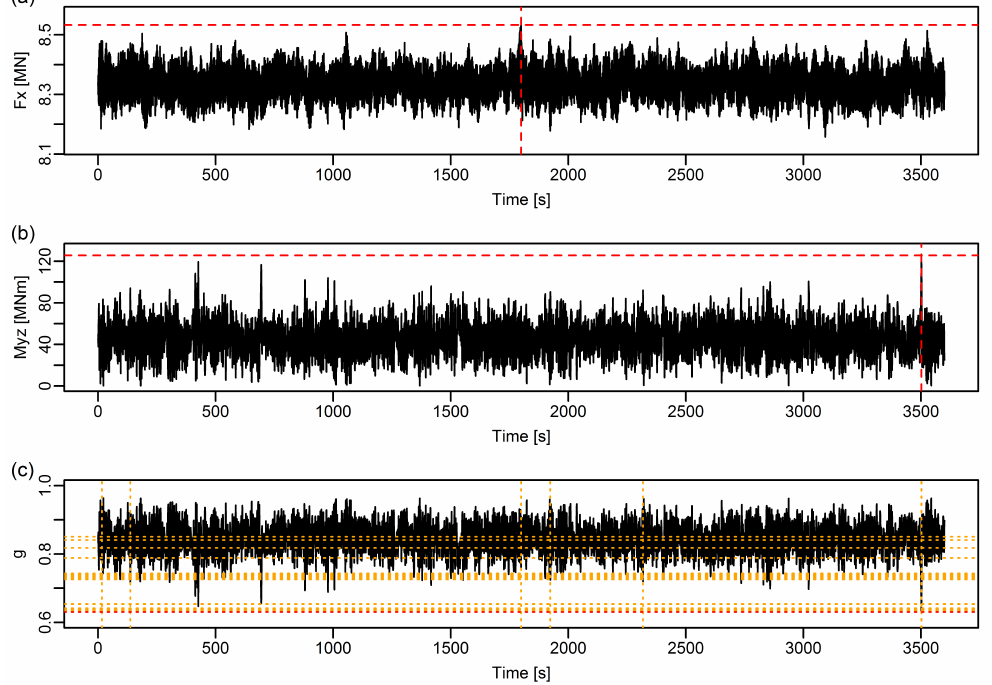
Figure 5. Illustration of the difference between Pareto-optimal loads and the standard approach for the mudline location in the OC3 monopile, at rated wind speed (Design Load Case (DLC) 1.3). ( a ) Axial force; ( b ) total bending moment. The broken red lines indicate the locations and values of the univariate maxima. ( c ) Limit state function for combined bending and compression. The broken red line indicates the value for the conservative combination of univariate maxima. The dotted orange lines indicate the locations and values at the Pareto-optimal points. The nominal value of yield strength was used, and zero manufacturing uncertainty was